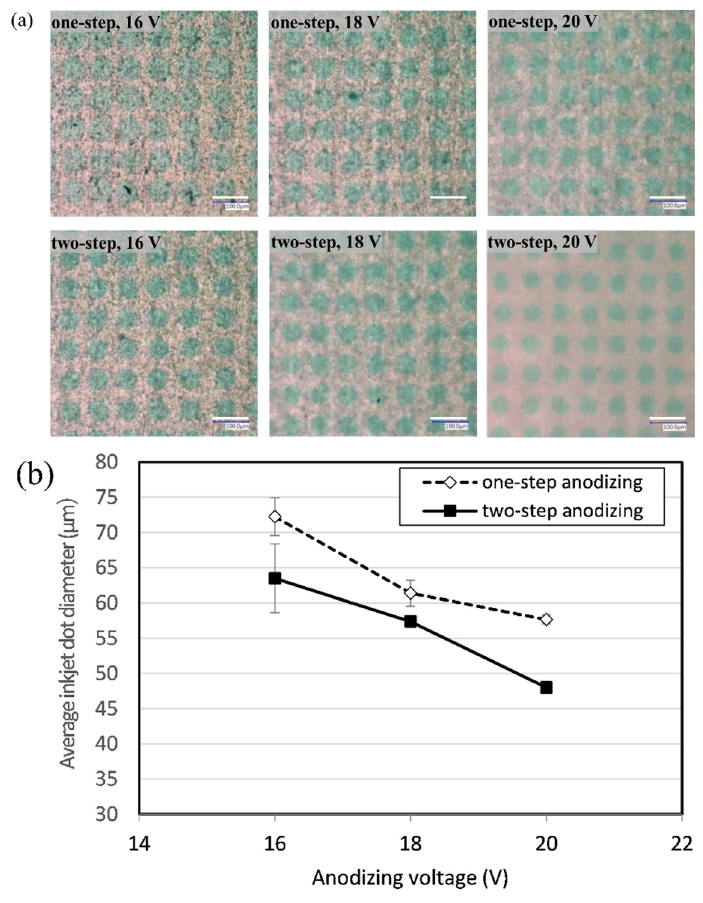
Figure 8. ( a ) Images of inkjet dot patterns on the AAO films produced by one-step and two-step anodizing with applied voltages of 16, 18, and 20 V (scale bar 100 μ m), and ( b ) the change in dot diameter (a drop volume of 13 pL) according to applied anodizing voltage.